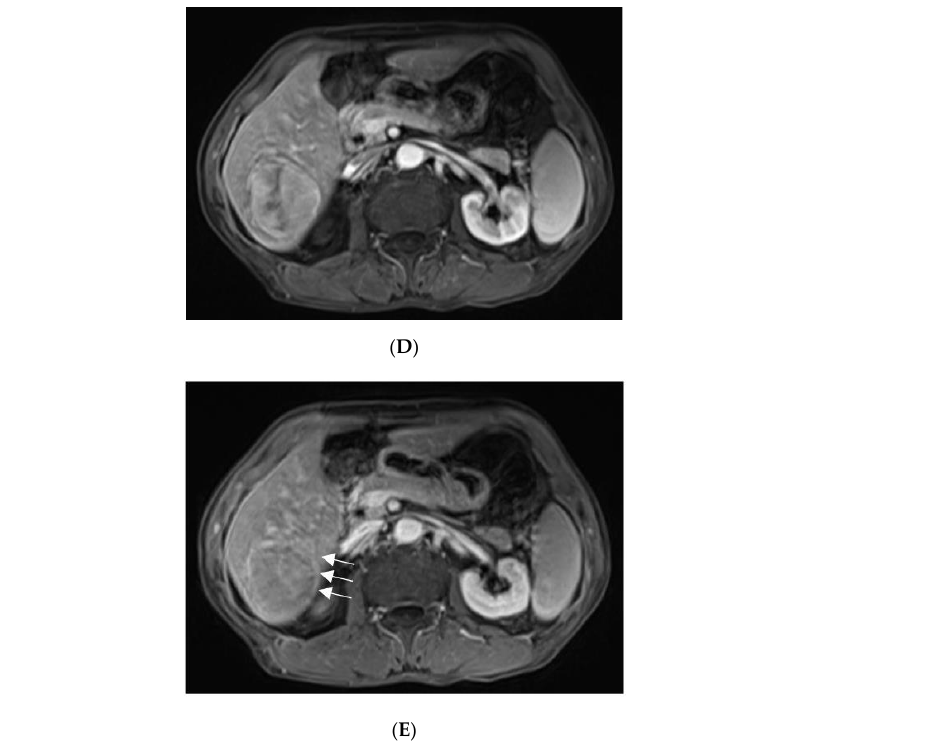
Figure 2. For further diagnosis, abdominal magnetic resonance imaging (MRI) was performed. The hepatic nodule was slight hyperintense on unenhanced T1WI ( A ). On T2WI, it was markedly hyperintense ( B ). On the contrast-enhanced scan, the hepatic lesion presented non-rim hyperenhancement in the arterial phase ( C ), but it was hypointense in the portal venous and late phases ( D ). The capsule-like hyperenhancement area was also observed in the late phase (( E ), arrow). According to the American College of Radiology Liver Imaging Reporting and Data System (LI-RADS), it was classified as LR-5 [1].